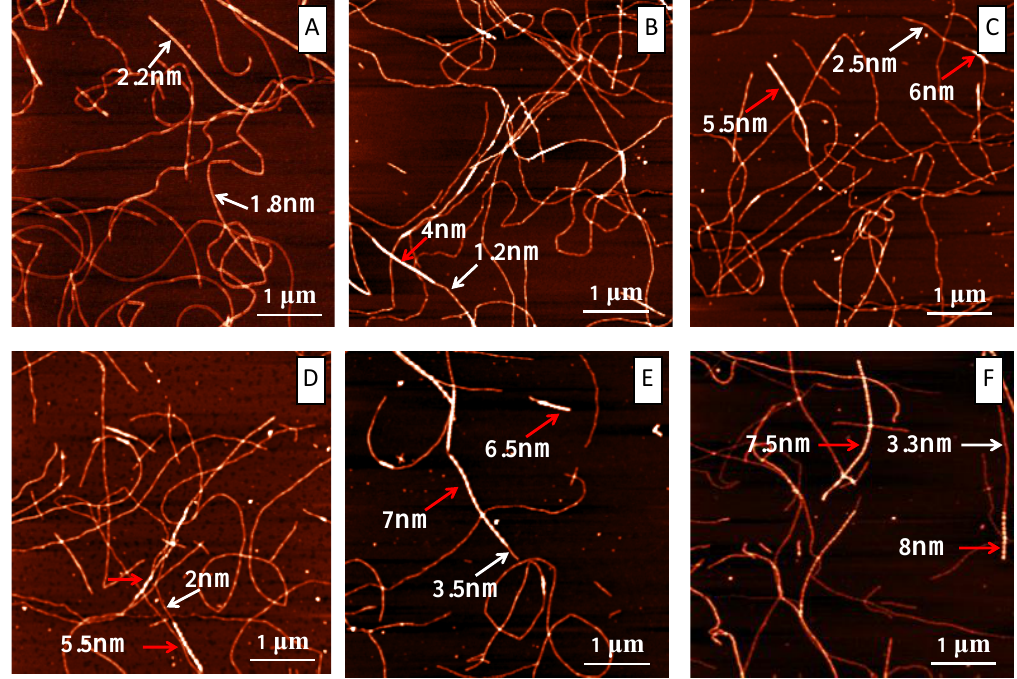
Figure 4. AFM characterizations of lysozyme fibrillation under the influence of different concentrations of tannic acid at the end of the incubation. ( A ) Control; ( B ) 150 µM; ( C ) 300 µM; ( D ) 600 µM; ( E ) 900 µM; ( F ) 1200 µM.